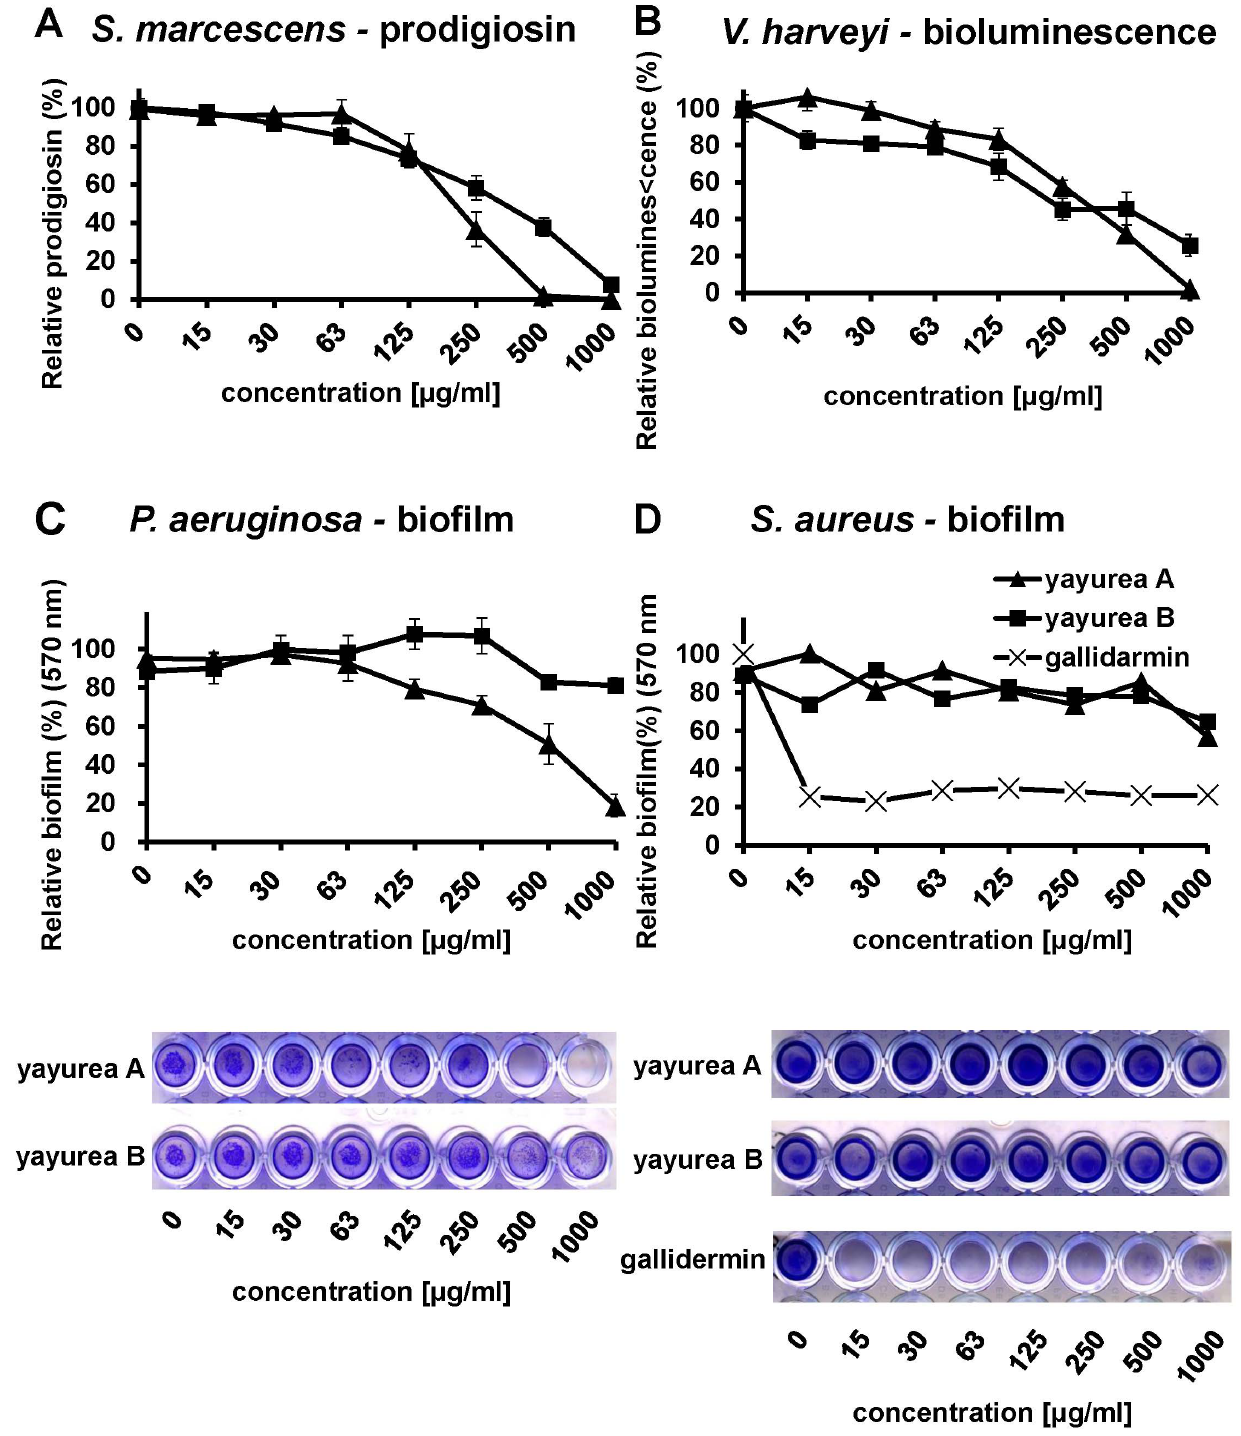
Figure 5. Concentration-dependent inhibition of QS-regulated phenotypes in Gram-negative bacteria. ( A ) Prodigiosin production in S. marcescens . Cells were grown in MB medium with serial dilutions of yayurea A or B at 28 u C. Relative prodigiosin production was calculated as the ratio between prodigiosin content (absorbance at 534 nm) and cell density (absorbance at 600 nm). ( B ) Bioluminescence in V. harveyi . Cells were grown in marine broth with serial dilutions of the compounds at 28 u C for 24 h. Relative luminescence units were normalized by the cell density. ( C ) Biofilm formation of P. aeruginosa . Cells were grown in LB with serial dilutions of yayurea A or B at 37 u C for 24 h. ( D ) Biofilm formation of S. aureus . Cells were grown in TSB with serial dilutions of yayurea A, B, or gallidermin (positive control) at 37 u C for 24 h. Biofilm cell layer was visualized by crystal violet staining and measured at 590 nm. Microtiter plates presented are representative of at least three independent sets of experiments. Bars indicate standard deviation of the mean, SD.